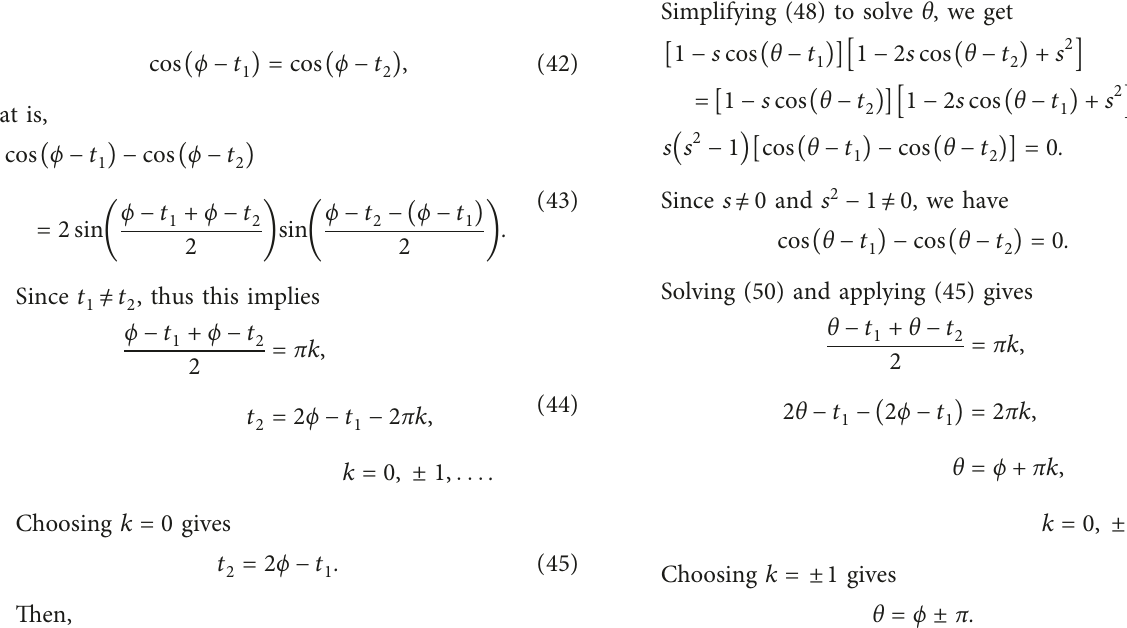
( t ) (bottom curve) for 1